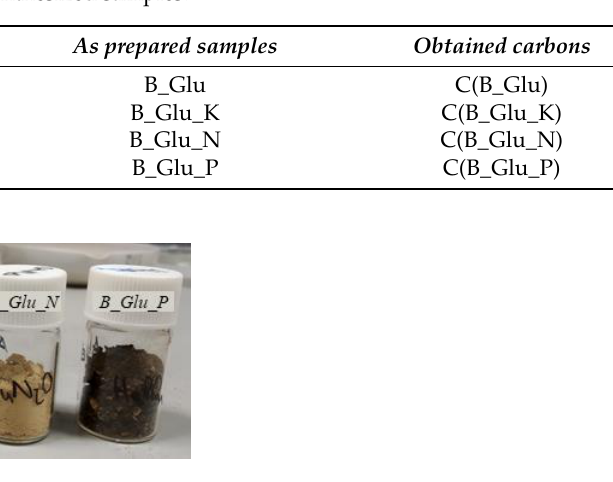
Figure 13. Samples of impregnated boehmite after drying at 100 °C for 16